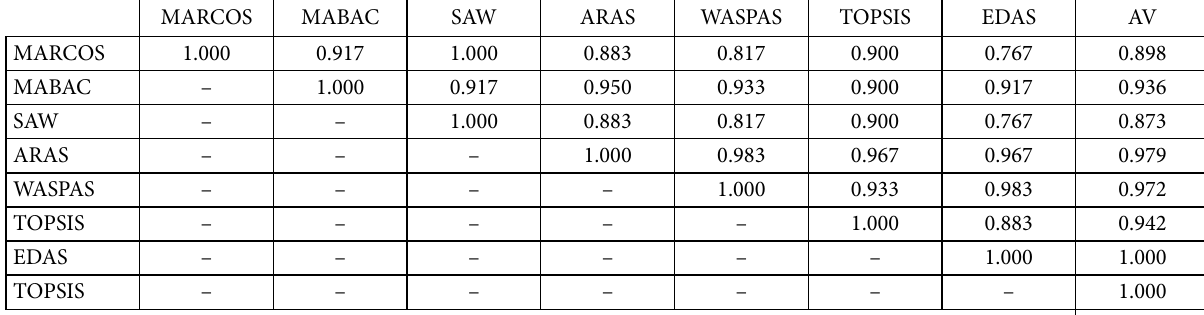
Table 4. SCC for the obtained ranks using different methods